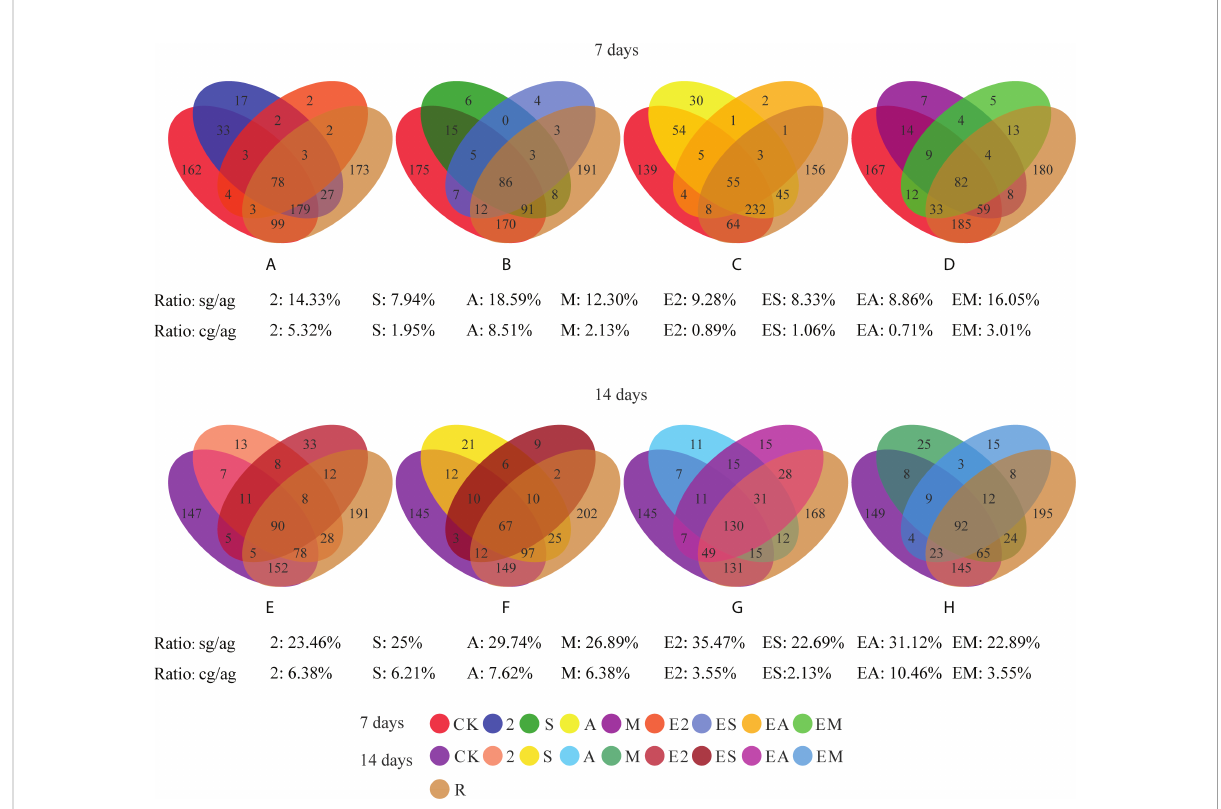
FIGURE 6 Venn diagrams showing the numbers of shared and unique bacterial genera in chemoattractant and chemoattractant-plus-chemotactic strain treatments at 7 (A – D) and 14 (E – H) days and in rhizosphere soils of a C. equisetifolia forest. sg, speci fi c genera. cg, common genera. ag, all